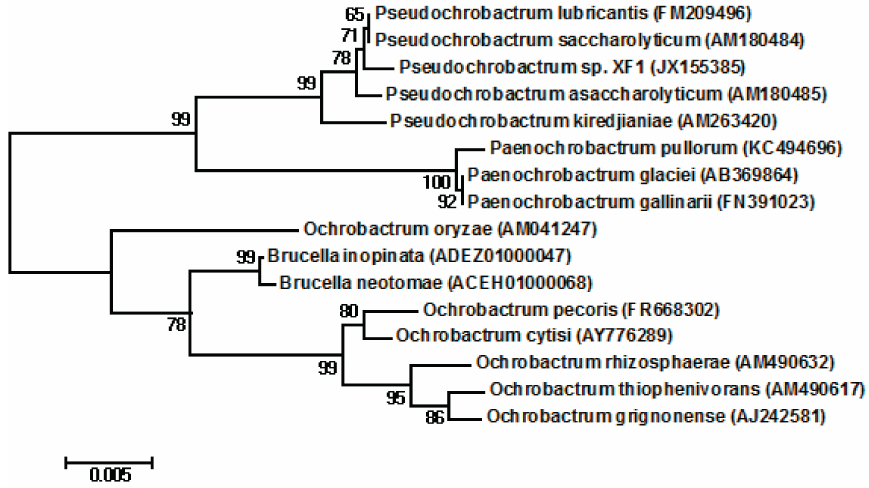
Figure 1. Phylogenetic tree showing relationships between Pseudochrobactrum sp. XF1 and related species. The tree was constructed from an alignment of the sequence of 16S rRNA using the neighbor-joining method. The number on the nodes represents the percentage of 1000 bootstrap replicates. The bar denotes the relative branch length.